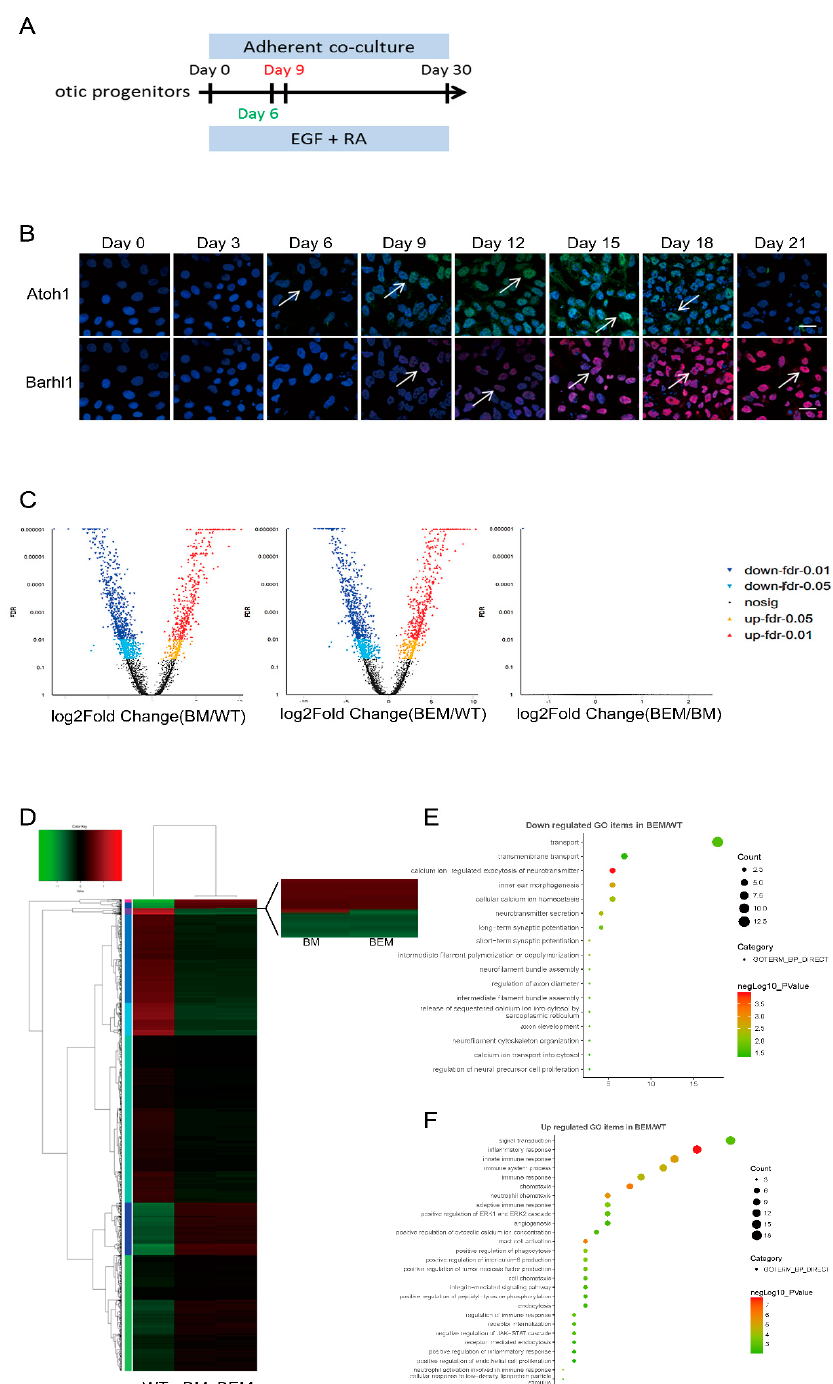
Figure 6. Barhl1 is involved in hair cell differentiation and functions. ( A ) The schematic diagram shows an otic progenitors differentiation protocol with time points when Atoh1 and Barhl1 begins to express, marked in green and red, respectively. ( B ) Analysis of Atoh1 and Barhl1 expressions at different time points during in vitro induction of otic progenitors towards hair cell-like cells by immunostaining. Scale bars, 30 µ m. ( C ) Differentially expressed genes-based volcano plot. Red dots and blue dots represent upregulated genes and downregulated genes in Barhl1 CDS mutated (BM)- (left) and BEM-derived (middle) cultures relative to WT-derived cultures, respectively ( | fold change